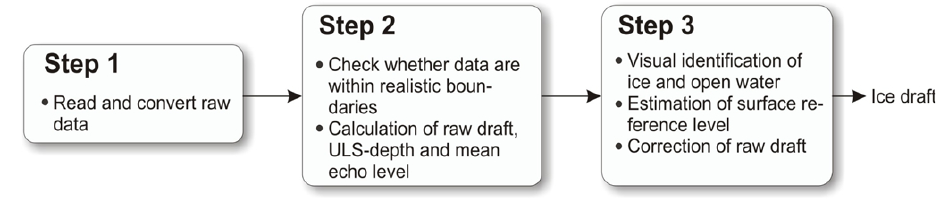
Figure 3. The ULS data processing chain. Table 1. Quantities contained in the data files.